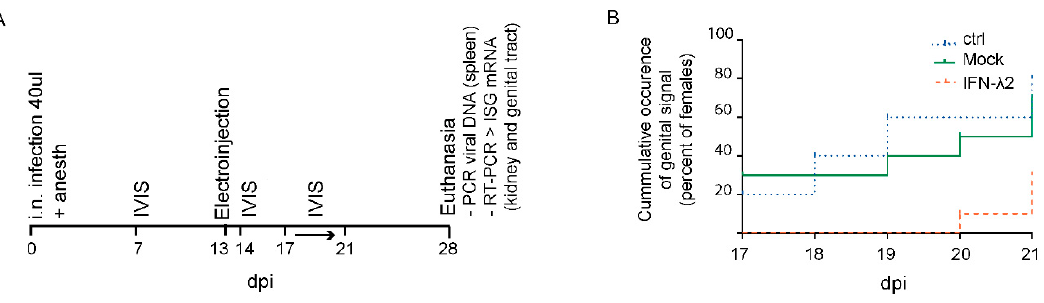
Figure 5. Luciferase signal occurrence in the genital tract of IFN- λ expressing mice. ( A ) Outline of the experiment: Eight week-old BALB / c female mice were infected by i.n. injection with 10 4 PFU Luc + MuHV-4 under general anesthesia. Thirteen d.p.i., mice were electroinjected with an empty plasmid (mock, n = 10) or a plasmid expressing IFN- λ 2 (IFN- λ 2, n = 10). A control group (ctrl, n = 10) was left untreated. To assay the influence of IFN- λ on genital tract colonization, mice were imaged every day from day 17 to 21 p.i. After sacrifice, upregulation of IFN-stimulated gene (ISG) induction was followed by RT-PCR and spleen infection was detected by PCR. ( B ) Non-significant di ff erence observed between groups in the occurrence of a genital signal from day 17 to 21 p.i. non-significant di ff erence by Log Rank test (Mantel–Cox): p > 0.05.